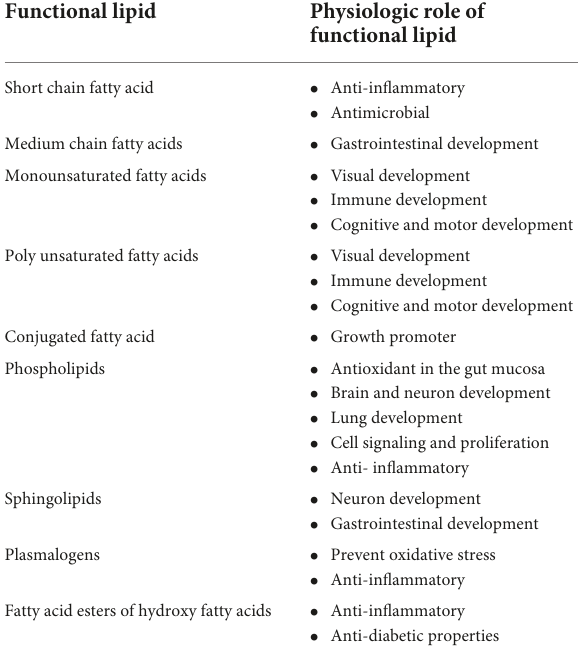
TABLE 1 The summarization of functional lipids and their